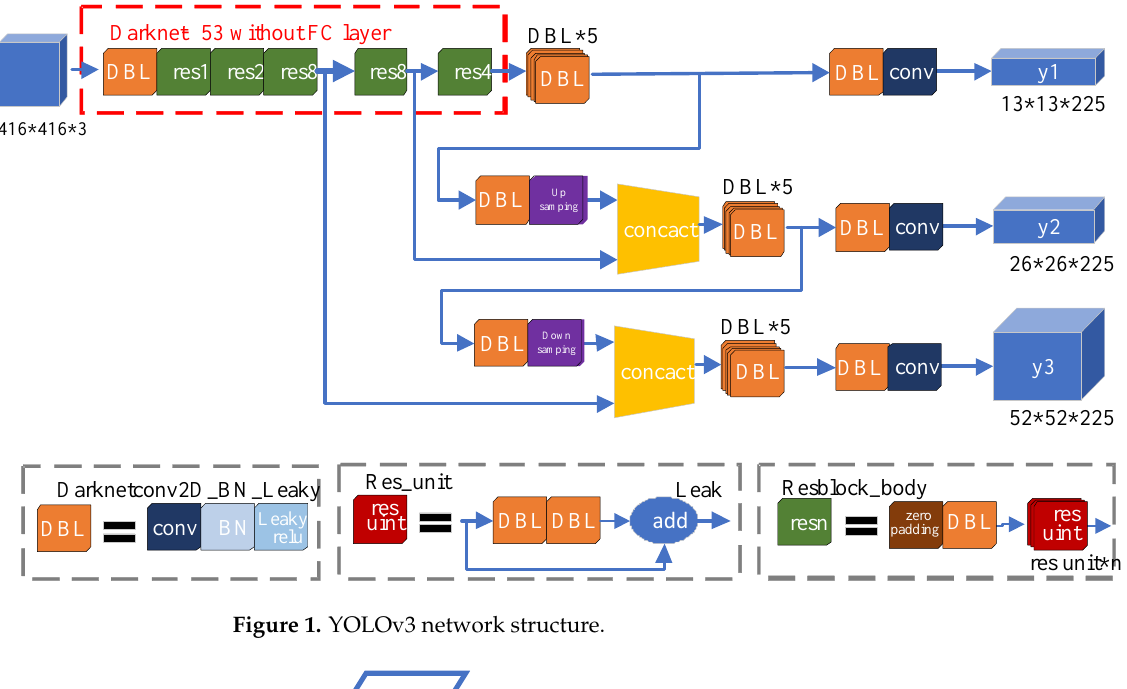
Figure 1. YOLOv3 network structure.